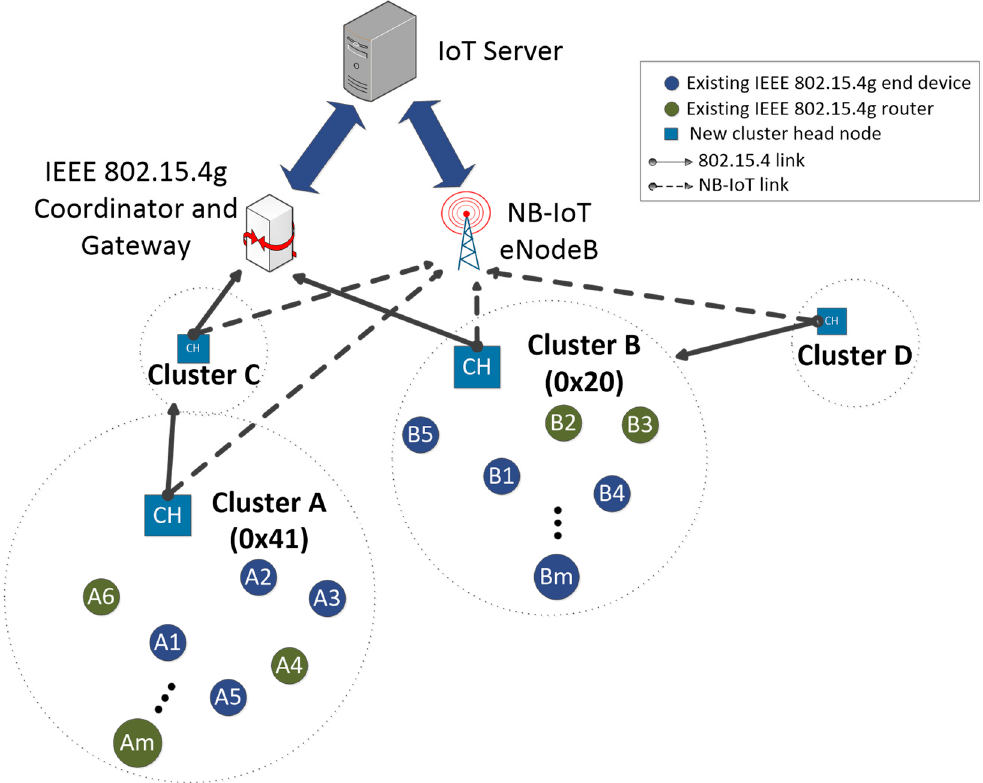
Figure 4. Network architecture with a cluster-tree topology [9].